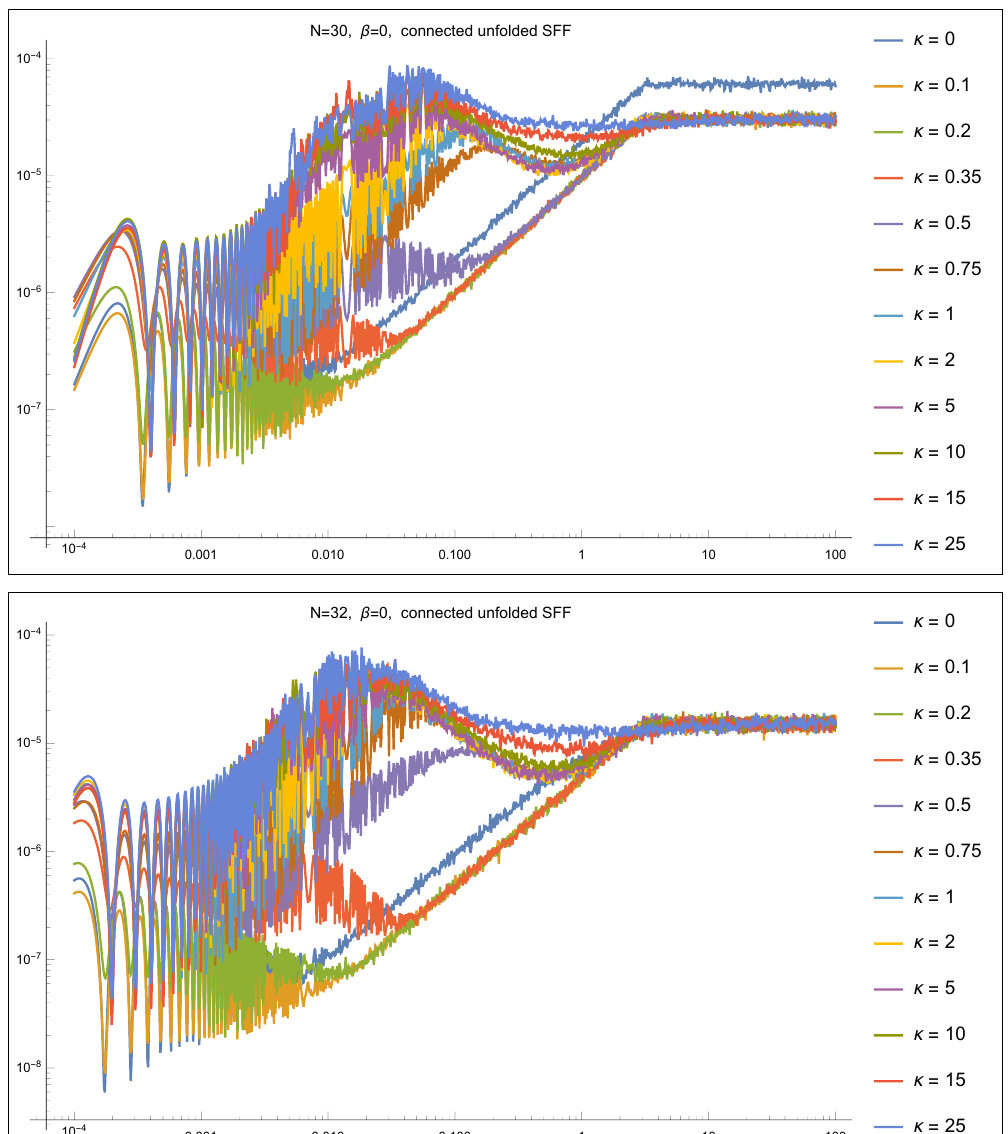
Figure 2 . The connected unfolded SFF for N = 30 ; 32 and (cid:12) = 0. The average is performed over M = 312 realizations for N = 30 and M = 150 realizations for N = 32